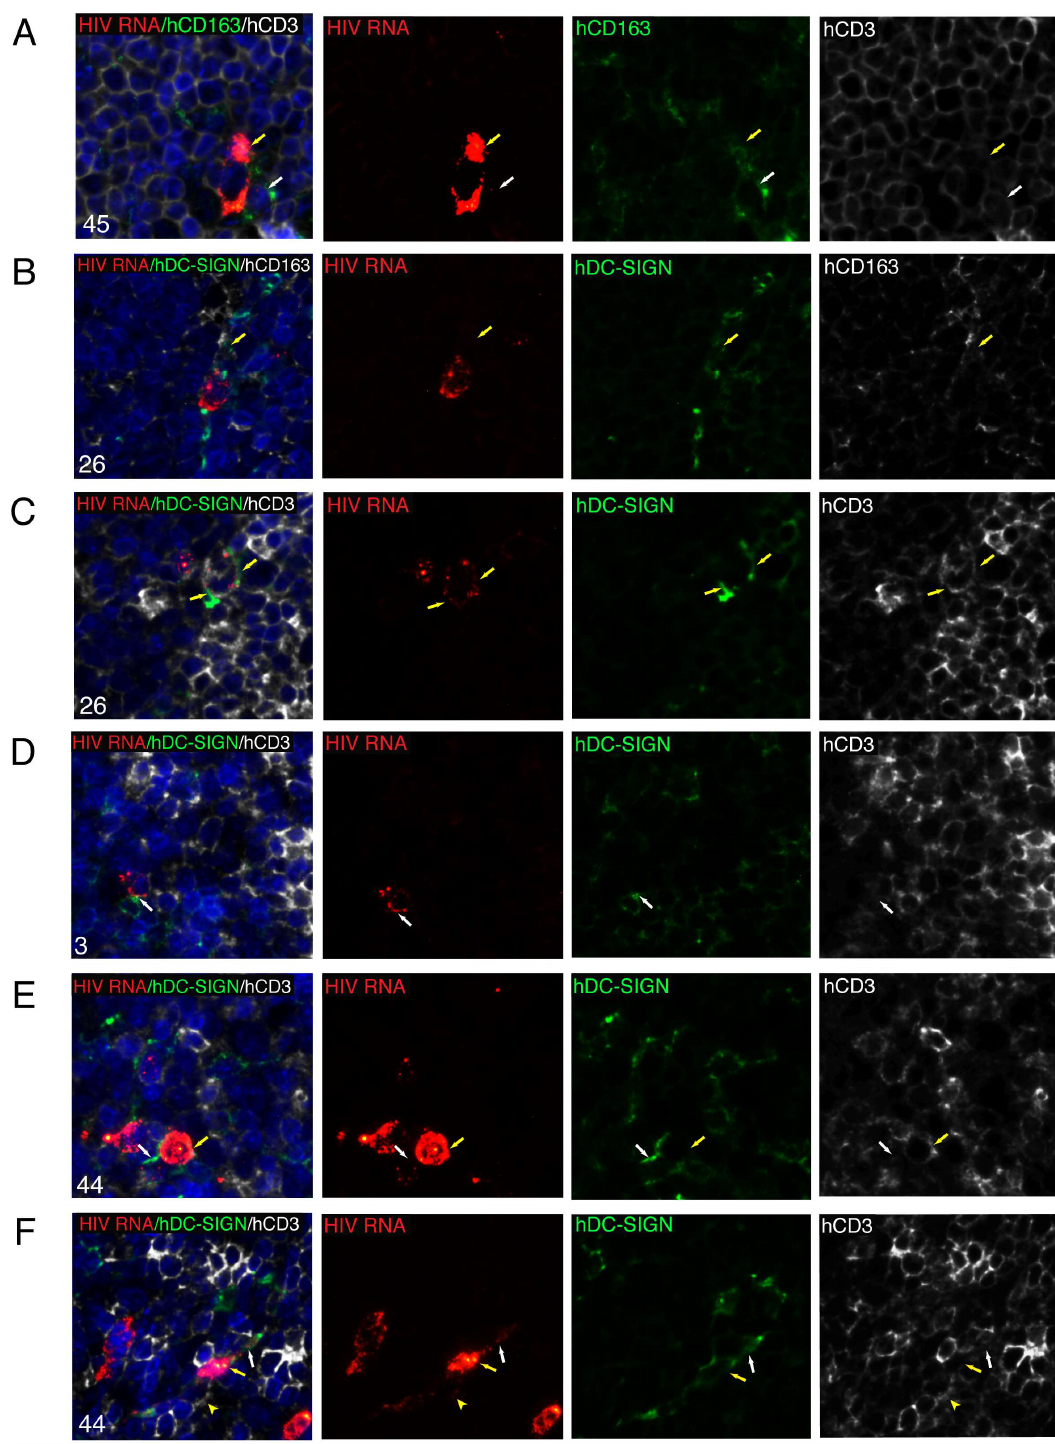
Figure 9. Tracking HIV spread in NSG-BLT mouse spleens 2 weeks after EFdA cessation. Multiplex fluorescent RNAscope ISH for HIV RNA and IHC for human ( A ) CD163 and CD3, ( B ) DC-SIGN and CD163, and ( C – F ) DC-SIGN and CD3 performed with spleens from HIV-inoculated NSG-BLT mice before EFdA treatment ( A ) and 2 weeks after drug cessation ( B – F ). The results are representative of those observed in at least 3 multiplex fluorescent RNAscope/IHC experiments with spleens from 5 or 6 mice per group. Nuclei were labeled with DAPI (blue). For the overlay images labeled with the mouse number, separate overlay panels are shown. The yellow arrow in A shows HIV RNA + T cell, and the white arrow shows an adjacent hCD163 + macrophage containing an HIV DNA signal in the